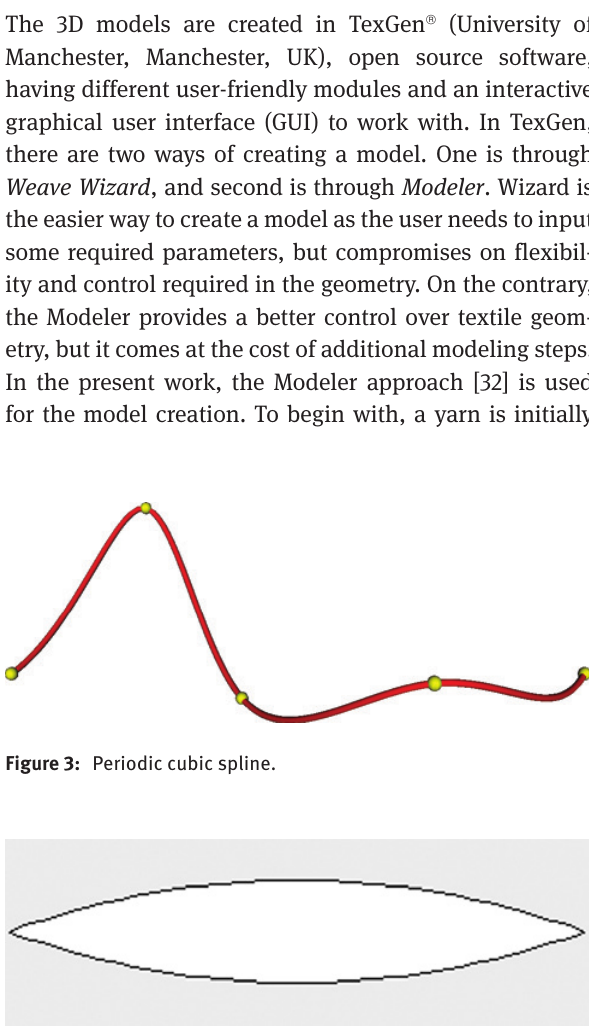
Figure 2: Schematic diagram of a weave fabric showing geometric parameters [4].